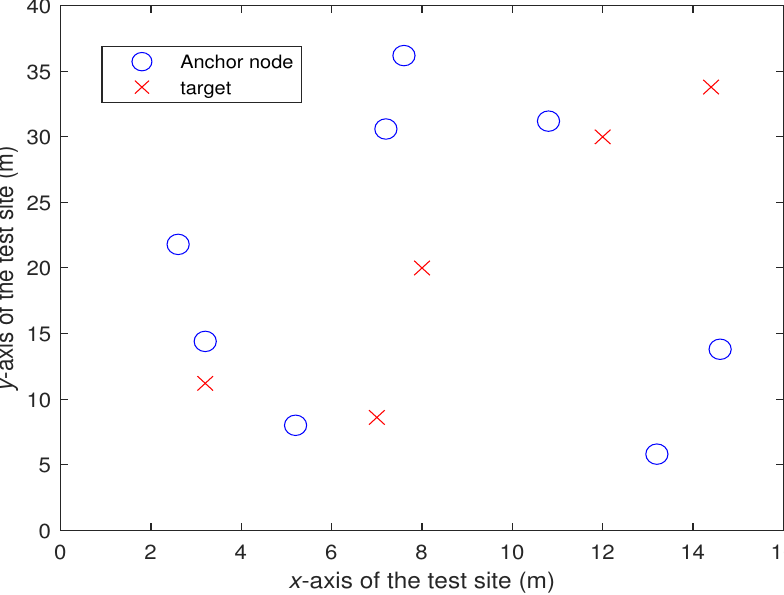
Figure 8. Distribution of the anchor nodes and the